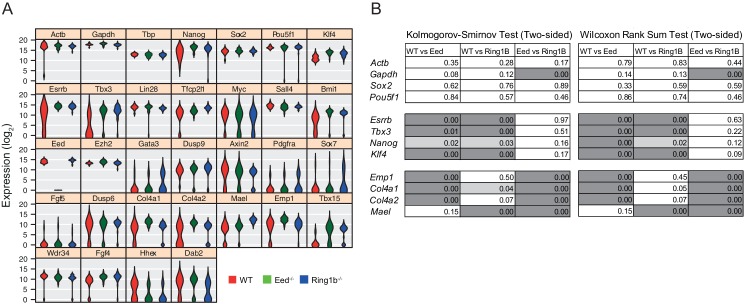
Single cell quantitative RT-PCR shows reduced cell to cell expression heterogeneity of key pluripotency and PrEn priming genes.(A) Violin plots showing the distribution of log2 gene expression values across WT (red), Eed-/- (green) and Ring1b-/- (blue) cells as determined by single cell qRT PCR for 32 candidate genes. (B) KS (indicated in Figure 3B) and Wilcoxon Rank Sum test results for the single cell Q-RT PCR data shown in Figure 3B.